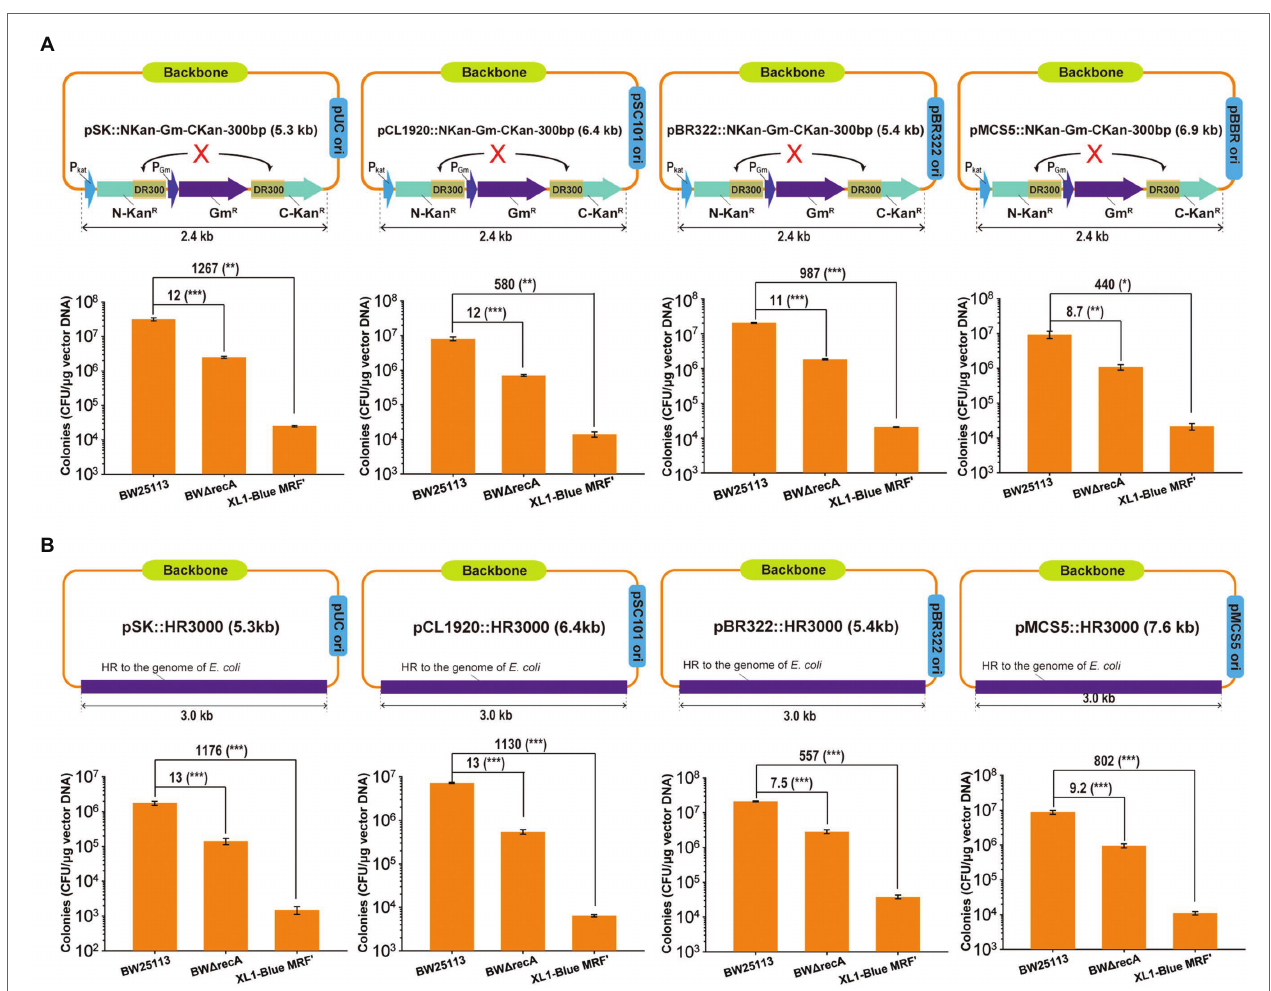
FIGURE 5 | The cloning efficiency by using E. coli BW25113, BW Δ recA, and XL1-Blue MRF’ as competent cells. (A) Artificial DNA fragment containing 300-bp direct repeats was assembled into plasmids with different replicons. (B) A 3 kb-DNA fragment homologous to E. coli chromosome was cloned into plasmids with different replicons. The assembled DNA constructs by using TEDA were transformed into the competent cells of three E. coli strains prepared with TSS and plated with antibiotic selection. The total colonies (transformants) were counted. The correct constructs were tested by PCR and the positive rates were all higher than 90% ( Supplementary Table S3 ). Data are averages of three samples with standard deviations (error bars). Unpaired t-tests were performed (* = p < 0.05; ** = p < 0.01; and *** = p < 0.001). Data are averages of three samples with standard deviations (error bars). The positive rates were reported in Supplementary Table S3